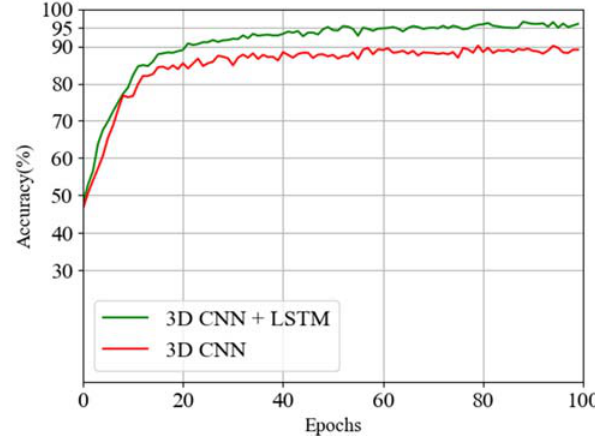
Figure 10. Two accuracy curves of using only point cloud data as input.